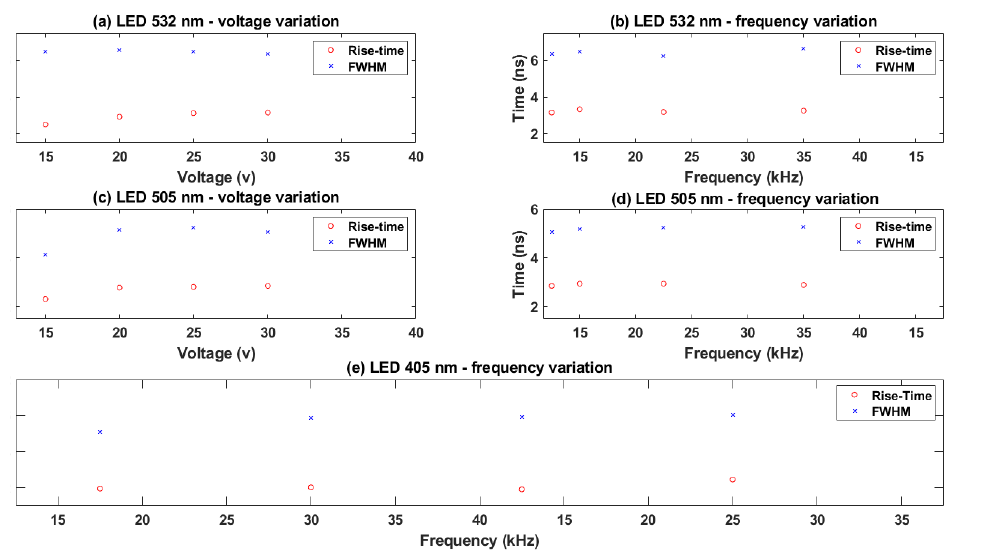
Figure 15. Optical pulse results for three different LED models at 532 ( a , b ), 505 ( c , d ), and 405 nm ( e ). The variation in the rise time and FWHM with respect to the voltage ( a , c ) and frequency ( b , d , e ) is presented for LEDs of 532 and 505 nm, while the variation with respect to frequency is presented for 405